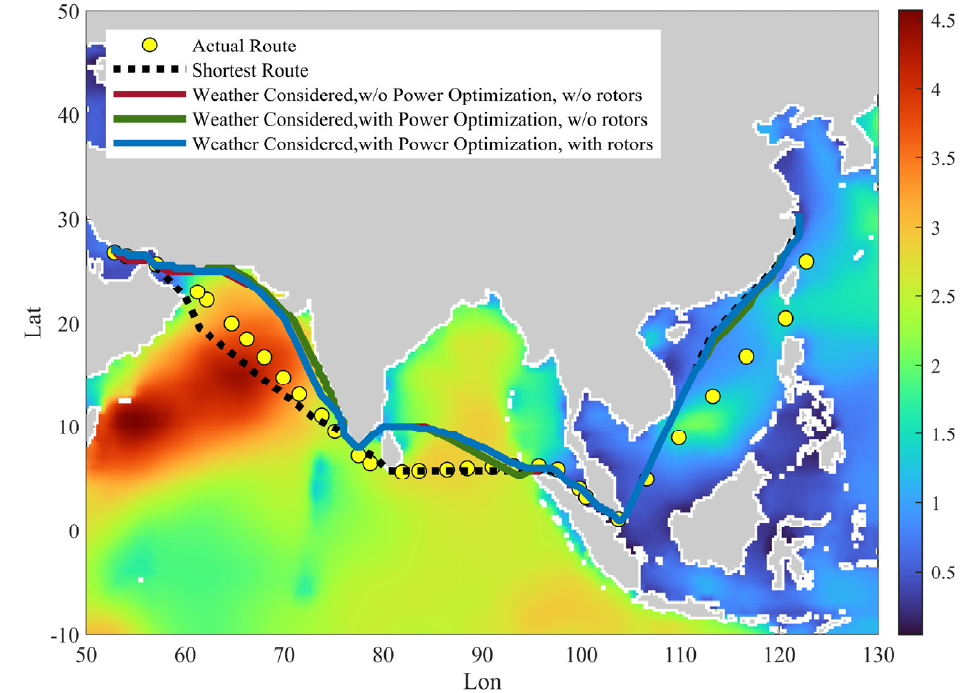
Figure 20. Result for ship weather routing for Case 6.